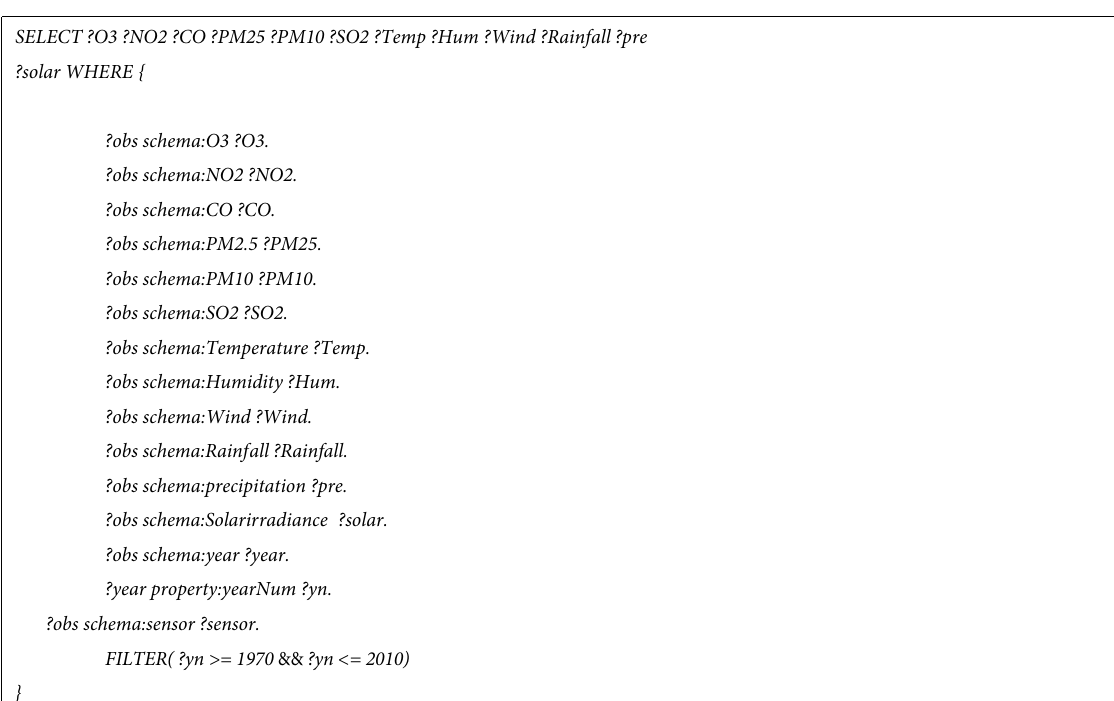
Figure 9: Dynamic query to retrieve all air quality and weather parameters filtered in different period of